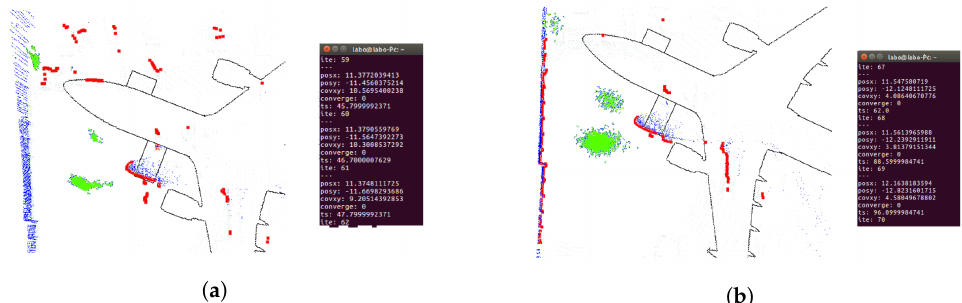
Figure 22. Convergence tests on Path 3 (Figure 16c) real flight with RANSAC PCL segmentation. Three-dimensional LIDAR point cloud (blue), 2D laser scans (red), AMCL particles (green). ( a ) UAV position before algorithm convergence. ( b ) The algorithm does not converge during the